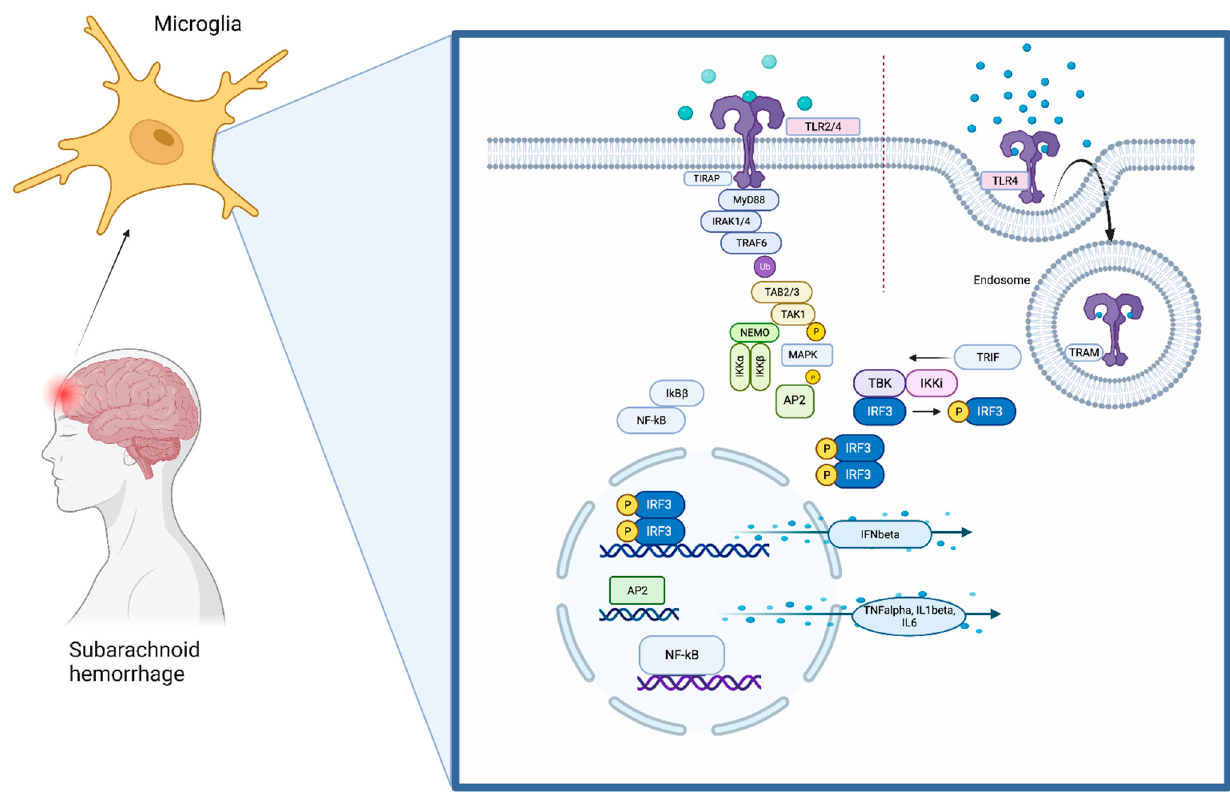
Figure 1. The TLR4 pathway. TLR4 is localized on the cell surface of microglia, where it senses DAMPs that are derived during brain damage. The TLR signaling pathway is activated by ligand-induced dimerization of receptors, followed by the binding of MyD88 and TIRAP or TRIF and TRAM. TLR4 translocates from the plasma membrane to endosomes with a switch from MYD88 to TRIF signaling. Activation of IRAK-1, IRAK-2, IRAK-4, and TRAFs leads to the activation of TAK1, TAK1-binding protein (TAB)1, TAB2, and TAB3. This complex phosphorylates and therefore activates IKK β , which again forms a complex with IKK α , IKK β , and NEMO. This leads to phosphorylation of NF κ B inhibitory protein, which consequently frees NF κ B. TAK1 is also involved in the phosphorylation and therefore activation of MAPKs. Transcription factors such as NF κ B and AP1 induce proinflammatory cytokines. Activation of endosomal TLRs leads to the production of interferons through transcription factor IRF3. Although TLR4 has the ability to use both pathway arms, TLR2 can only signal through the MyD88-dependent pathway.